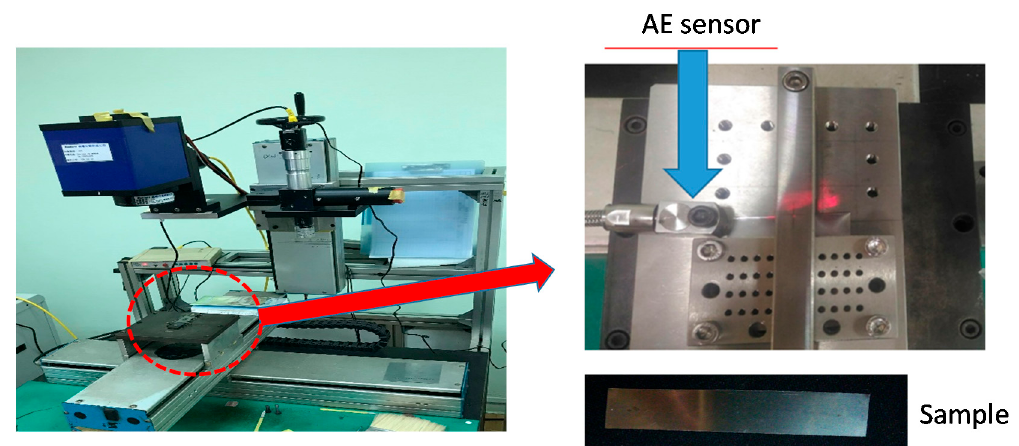
Figure 1. Laser welding research platform and fixture.